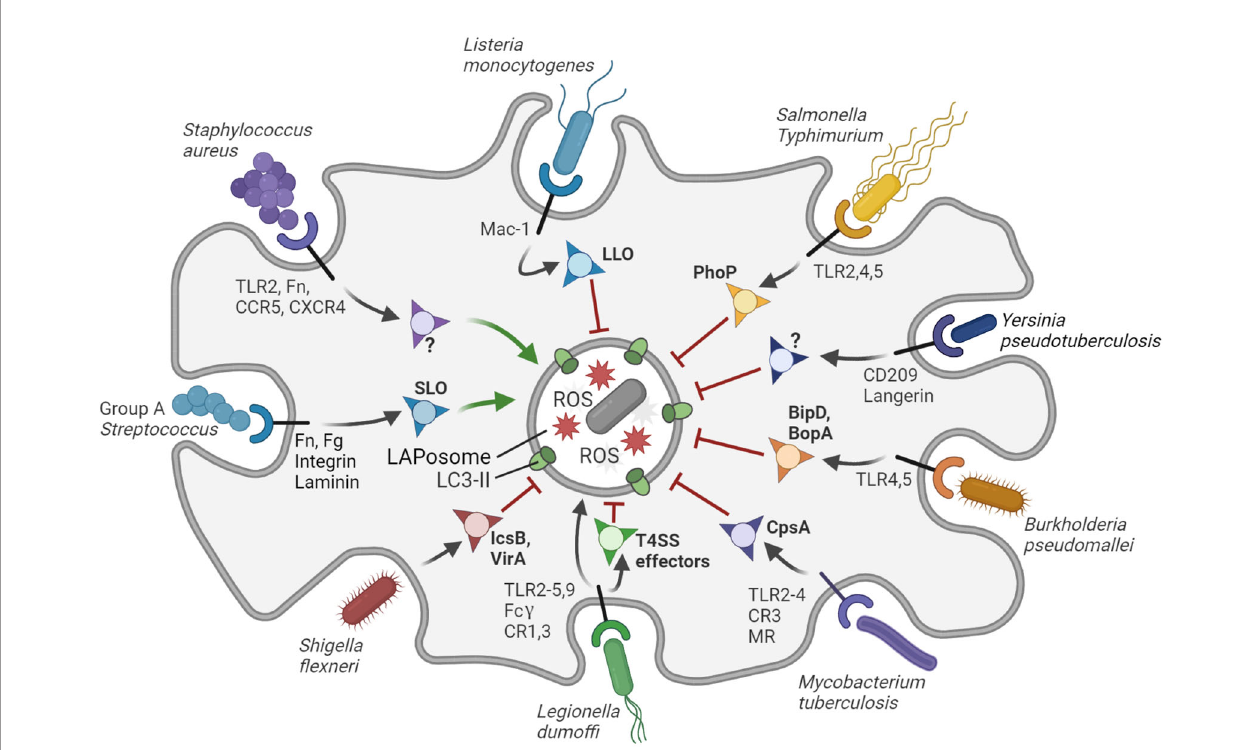
FIGURE 2 | Interactions of bacterial pathogens with LAP. The LAPosome is a single membrane vesicle marked by LC3-II and producing ROS. LAP contributes to host defense, but bacterial pathogens have evolved diverse ways to inhibit (red arrows) or promote (green arrows) LAP to their own bene fi t. S. aureus promotes the formation of LAPosomes in neutrophils via an unknown virulence factor to establish a replicative niche. Group A Streptococcus promotes LAP via the virulence factor SLO to evade bactericidal xenophagy. L. dumof fi is effectively degraded in the LAPosome (black arrow), although it may inhibit LAP to some extent via T4SS effector proteins. All other bacterial pathogens shown in the fi gure can partially inhibit LAP in phagocytes or LAP-like processes in epithelial cells through the virulence factors indicated. Virulence factors that remain to be identi fi ed are indicated with question marks. The receptors that mediate entry and/or immune recognition by the host phagocytic cells are shown, except for S. fl exneri , which attaches to surface proteins of M-cells in the gut epithelium. Figure created with